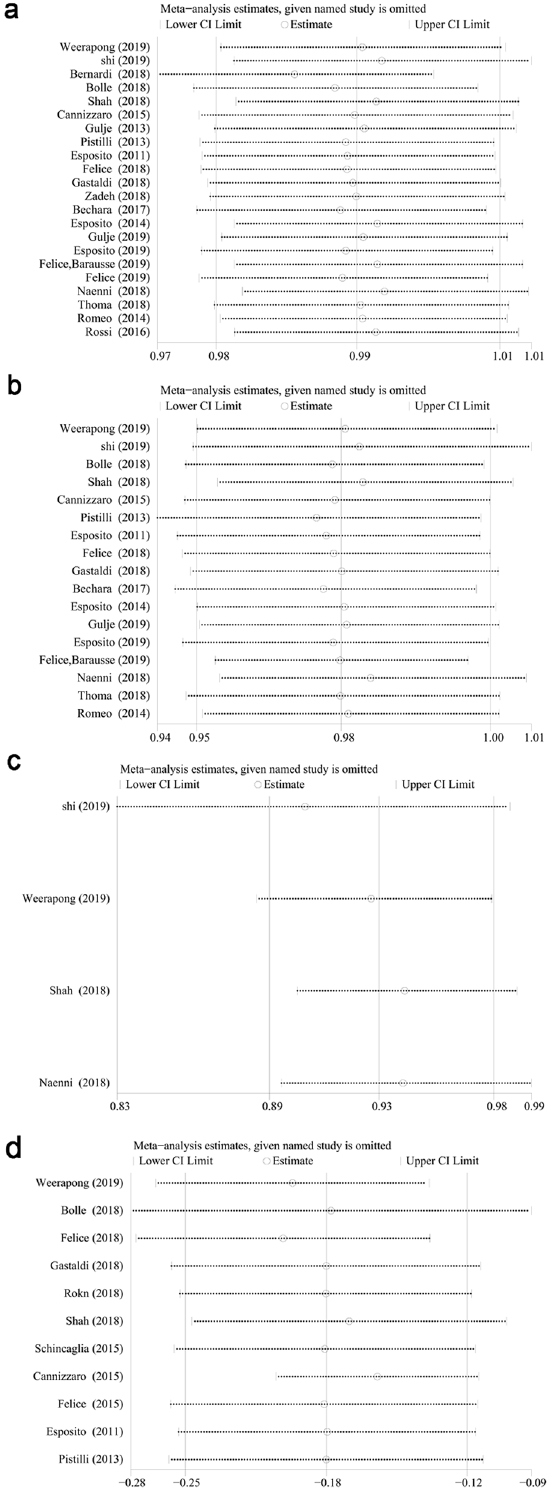
Figure 6. One-out remove graph in survival rate at implant ( a ) and patient level ( b ). One-out remove graph in survival rate (studies with adjustment for within-patient correlation) ( c ) and WMD of MBLs from implant placement at 1-year ( d